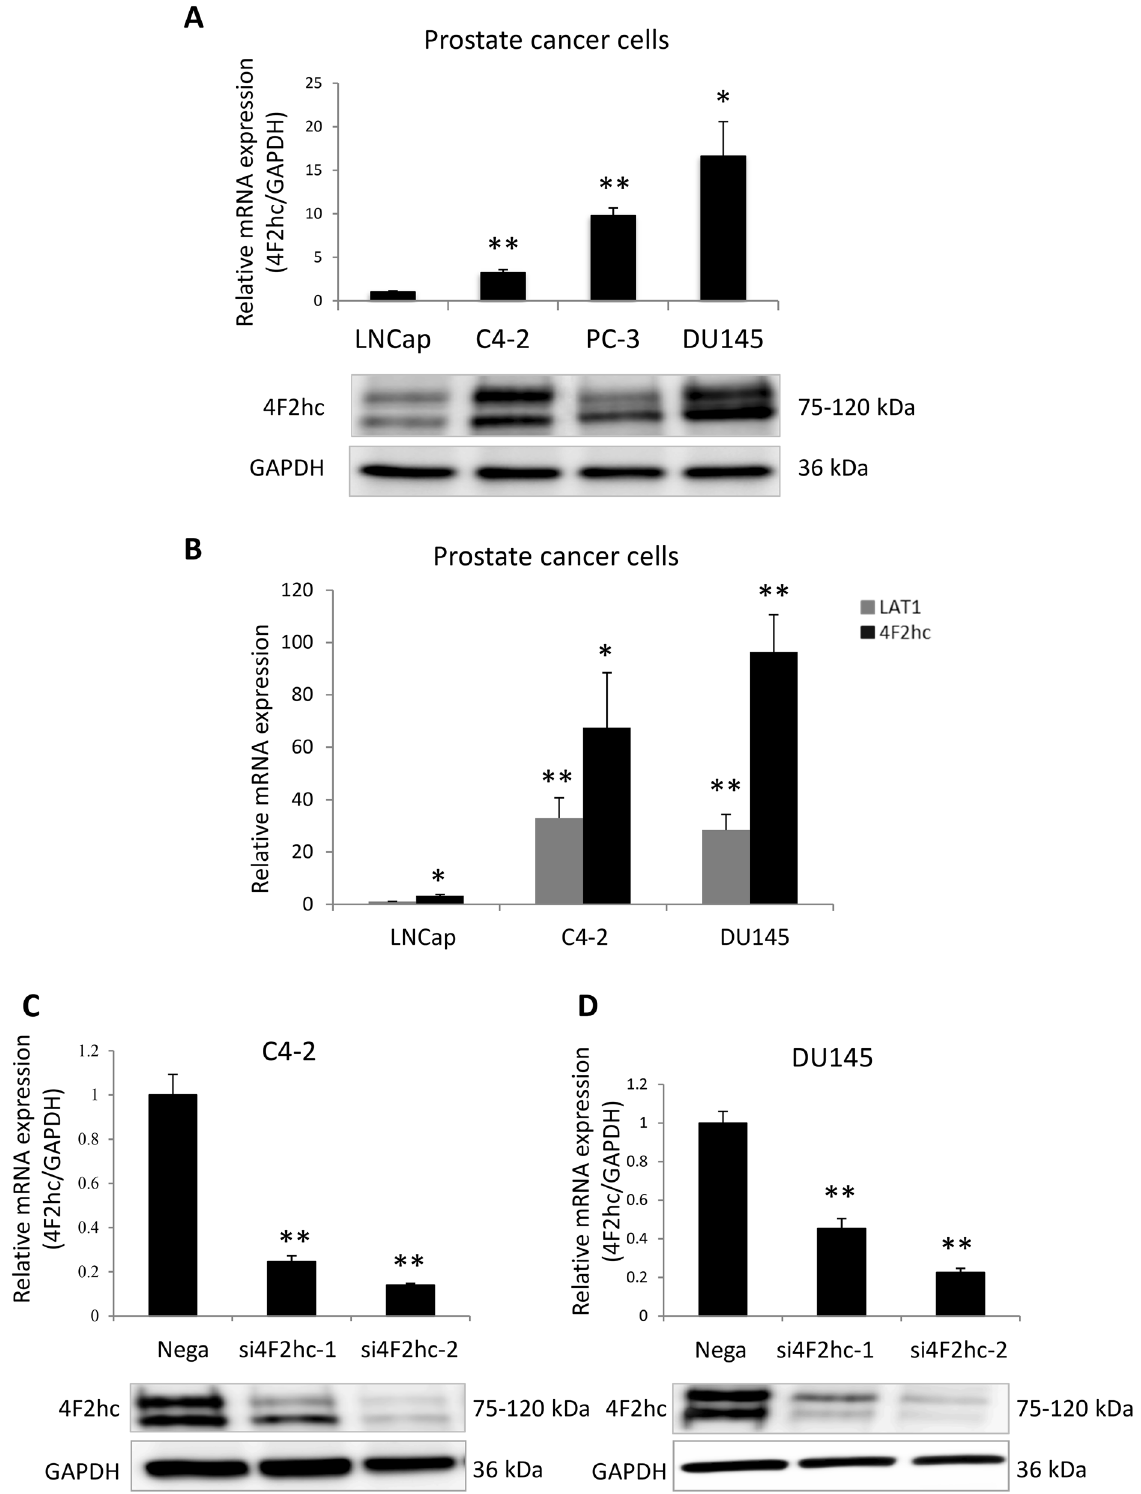
Figure 1. Expression of 4F2hc and LAT1 in PC cells and knocked down. Expression of 4F2hc in PC cells and functional significance of 4F2hc in PC cells. 4F2hc protein and mRNA levels were examined in PC cells ( A ). LAT1 mRNA and 4F2hc mRNA levels were examined in C4-2 and DU145 PC cells ( B ). Si4F2hc (si4F2hc-1 and si4F2hc-2) has significantly knocked down 4F2hc expression in C4-2 ( C ) and DU145 ( D ) cells. Nega indicates negative siRNA control. Data represent three independent experiments with similar results. P-values were calculated by the Mann–Whitney U-test. ** p < 0.01, *** p <